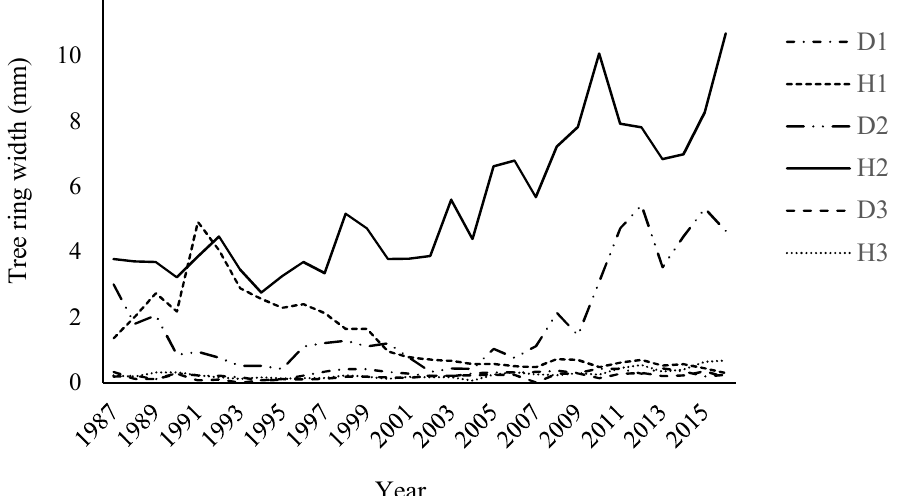
Figure 3. Time series of annual ring width of Quercus brantii for declined (D1–D3) and healthy trees (H1–H3).